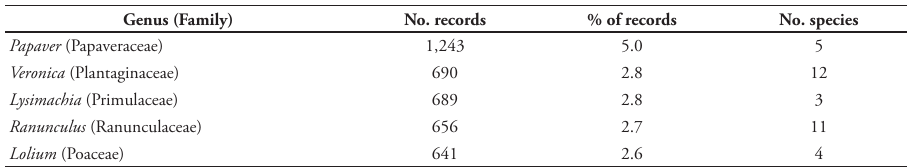
Table 2. The five most represented genera in the “Segetal flora of Italy” dataset: family, number of re- cords, percentage of records and number of species are reported for each genus.